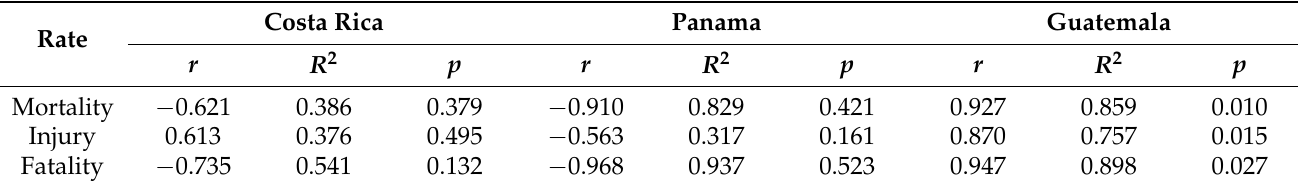
Table 4. Trend-over-time analyses for MVC-related mortality, injury, and fatality rates for 0 to 14-year-olds in Costa Rica, Guatemala, and Panama 2012–2015. Costa Rica Rate